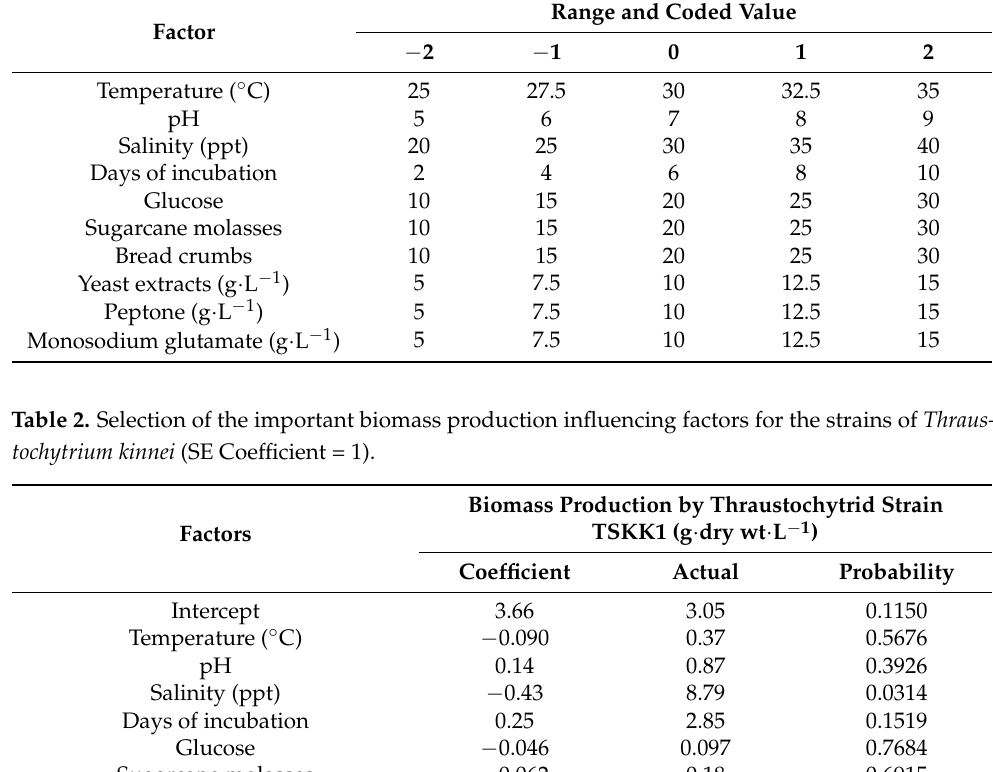
Table 1. Experimental range and levels of independent variables. Factor